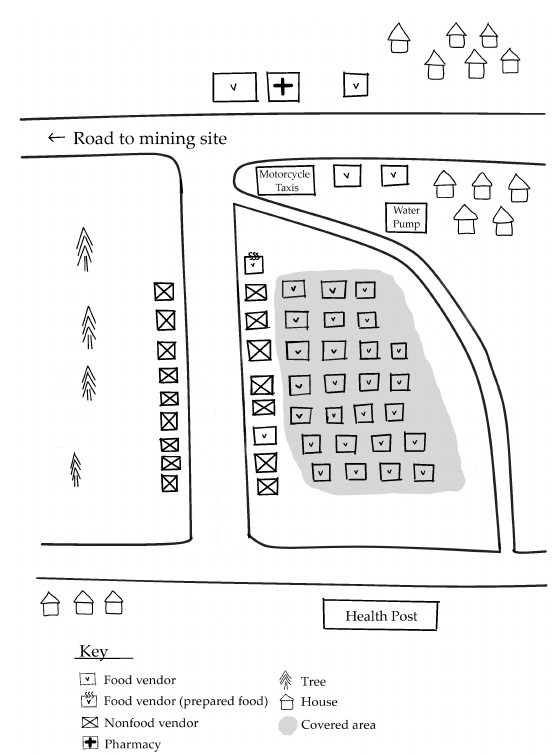
Figure 1. Map of market located in village center. Typical of a market where most food vendors sell unprepared foods.